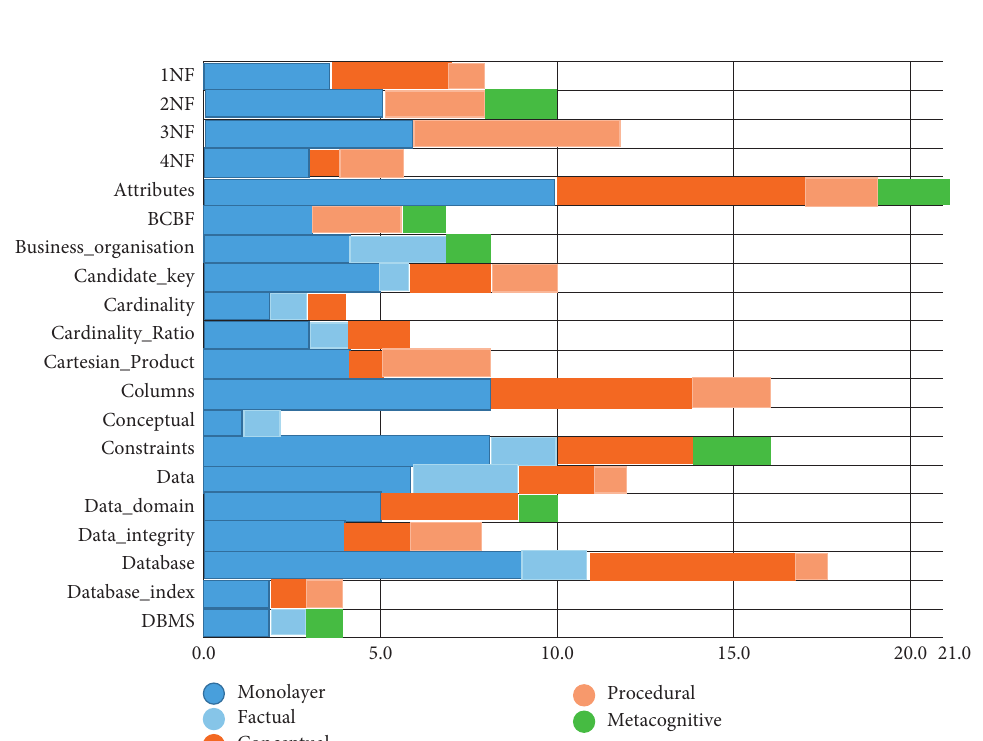
Figure 3: Diagnostic analysis of degree measure in MKN shows relations across